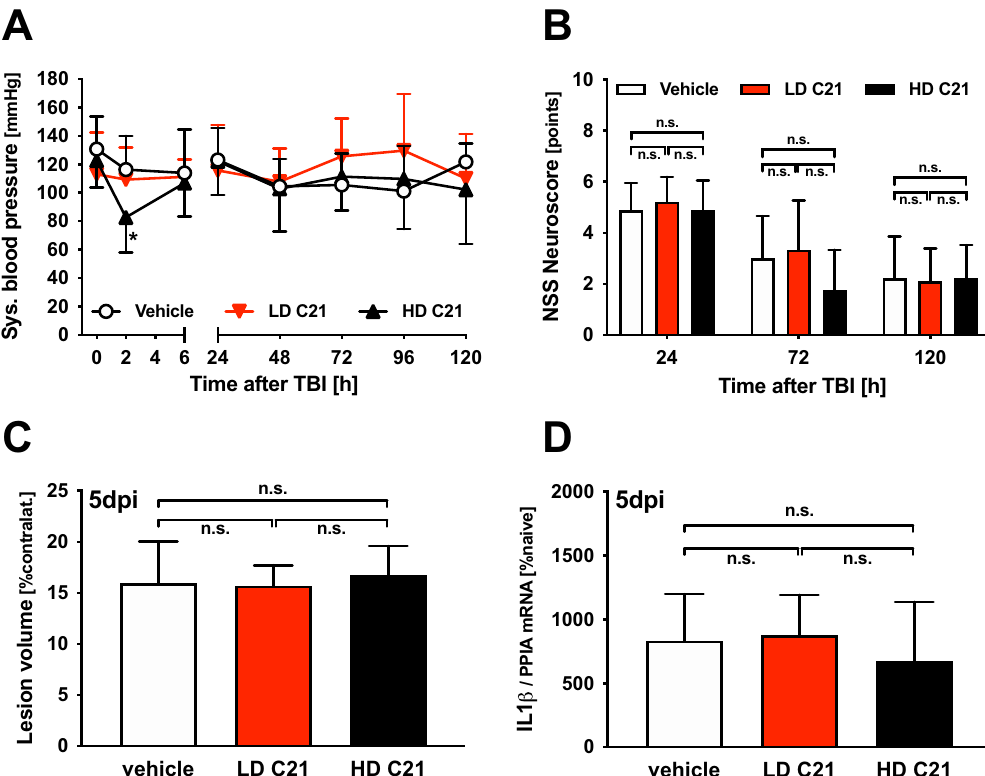
Figure 1. Effect of AT2 activation with C21 on blood pressure, neurological outcome, lesion volume and cerebral inflammation: Vehicle-treated WT mice ( n = 9; white) were compared to WT mice treated with low (0.03 mg/kg; LD C21; n = 9; red), or high dose (0.1 mg/kg; HD C21; n = 9; black) of C21; the data are expressed as mean ± SD; n.s. = not significant. ( A ) Peritraumatic systolic blood pressure (time point 0 during anesthesia, postoperative in awake animals): while there were no significant changes of blood pressure in the vehicle and LD groups, in the HD group there was a limited drop of blood pressure 2 h after CCI compared to the vehicle- treated group (* p = 0.035). At later time points, the values were within physiological levels, independent of the treatment. ( B ) NSS: one day (24 h) after TBI in all treatment groups, there was a significant increase in the neurological impairment followed by a significant improvement the following days in all groups. Treatment with C21 in both dosages did not affect neurologic outcome compared to the vehicle. ( C ) The cerebral lesion volume difference between treatment groups. ( D ) Five days after TBI (5 dpi), the perilesional gene expression of the cytokine IL1β was not affected by AT2 activation with C21 in both dosages compared to the vehicle